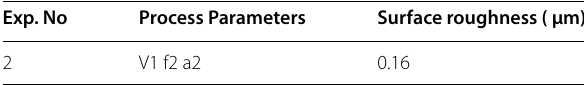
Table 8 Optimum process parameters